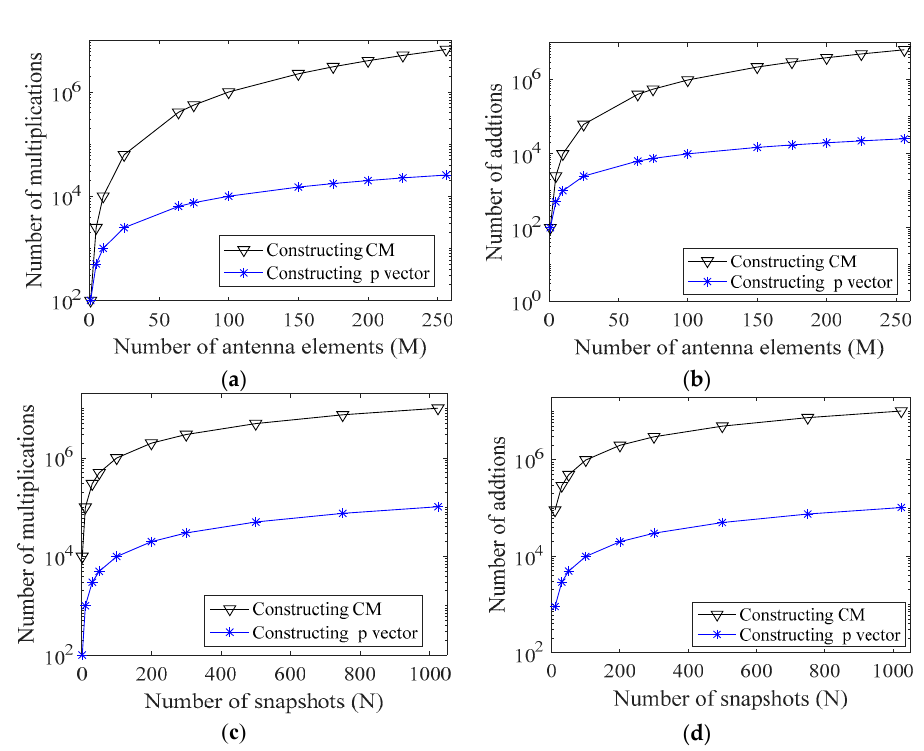
Figure 2. Comparison of complexity for covariance matrix (CM) and propagator vector ( p ) construction. ( a ) Multiplications required for N = 100 and M = 1:256; ( b ) Additions required for N = 100 and M = 1:256; ( c ) Multiplications required for M = 100 and N = 1:1000; ( d ) Additions required for M = 100 and N = 1:1000.